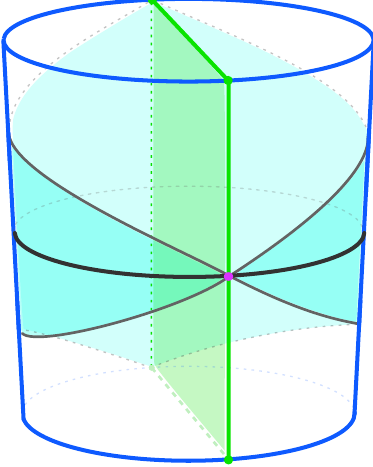
Figure 18. The Poincare patch models a zero temperature extremal black hole. The brane intersects the CFT Poincaré patch at the origin and